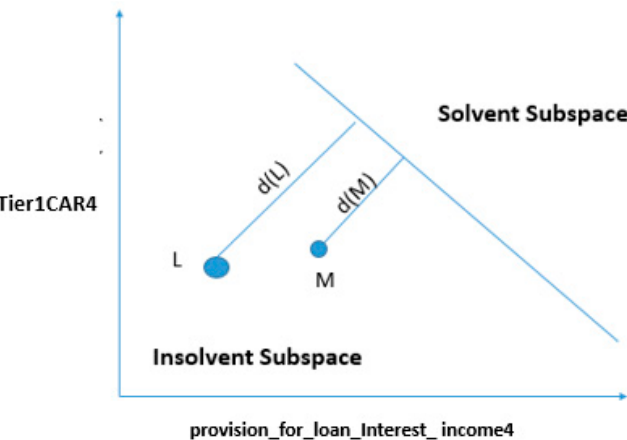
Figure 7. Quantifying and comparing the financial health of failed banks.